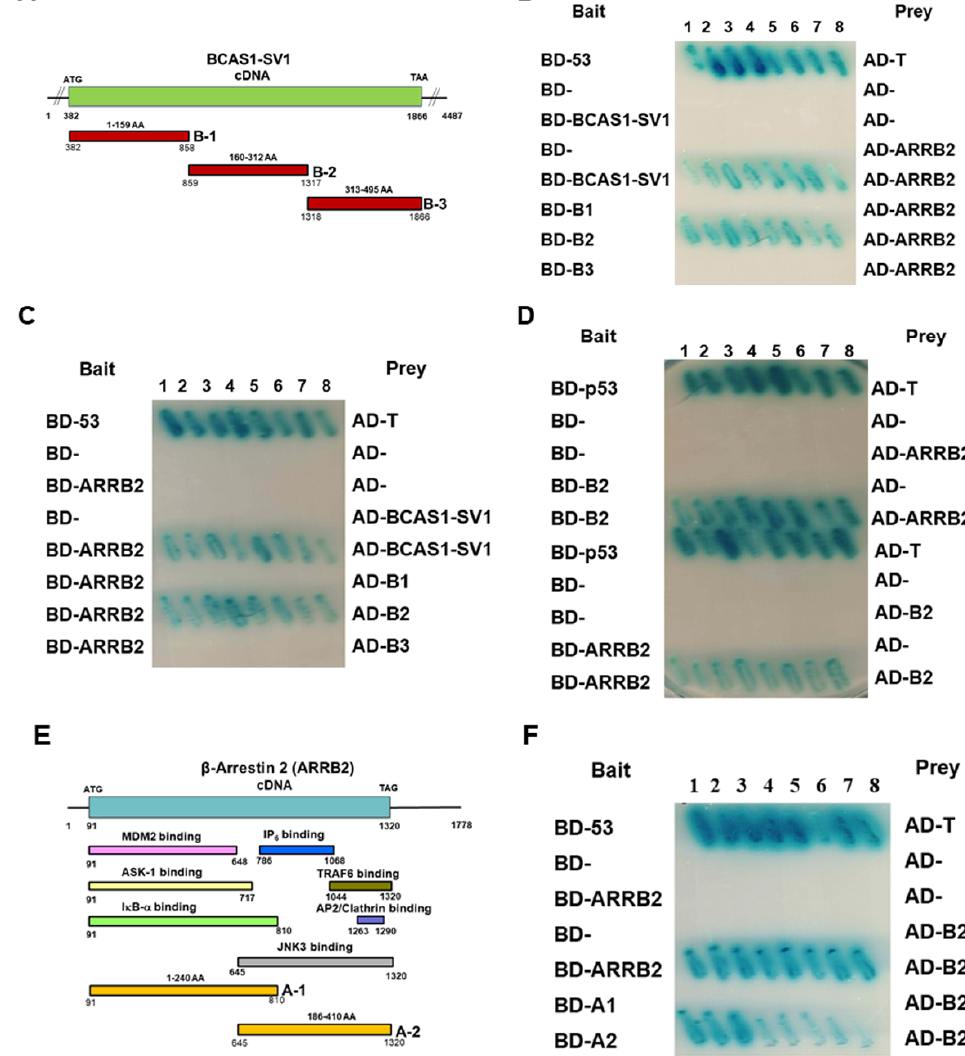
Figure 5. BCAS1-SV1 interacts with the c-terminus of β -arrestin through an intermediate region. ( A ) Schematic drawing of the deletion mutants of BCAS1-SV1 used in the yeast two-hybrid assay. ( B – D ) The B2 fragment of BCAS1-SV1 (160–312 amino acid) interacted strongly with β -arrestin 2. Dip- loid cells (blue) contain four reporter genes that are activated in response to two-hybrid interactions. Diploid cells containing BD-p53 and AD-T were used as a positive control. ( E ) Schematic drawing